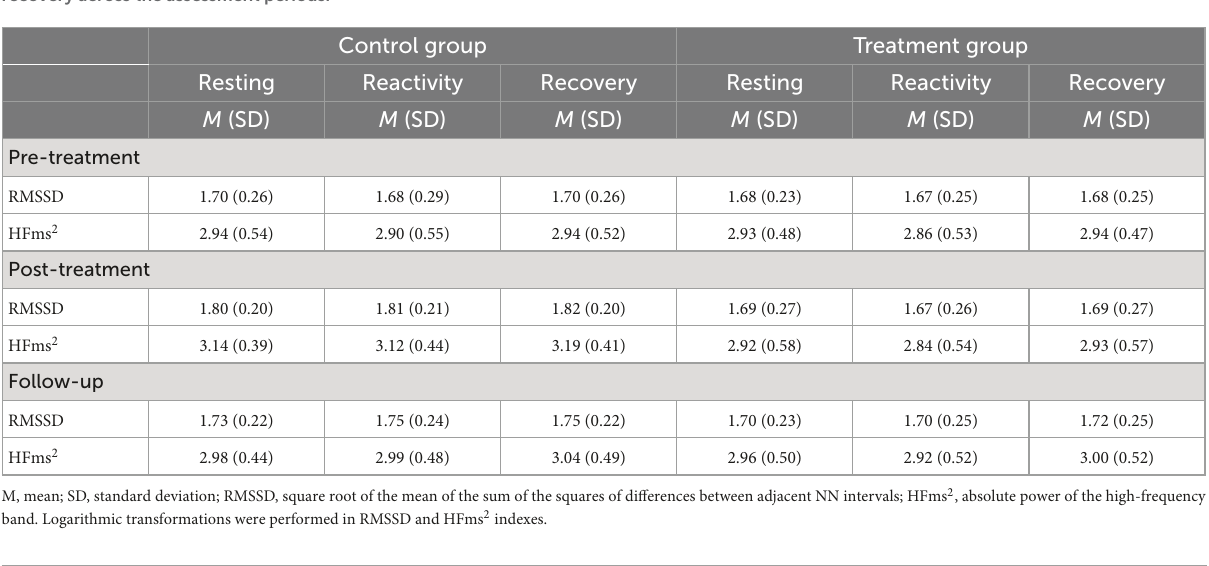
TABLE 1 Mean scores and standard deviations of the physiological correlates for the treatment and control groups at resting, reactivity, and recovery across the assessment periods.